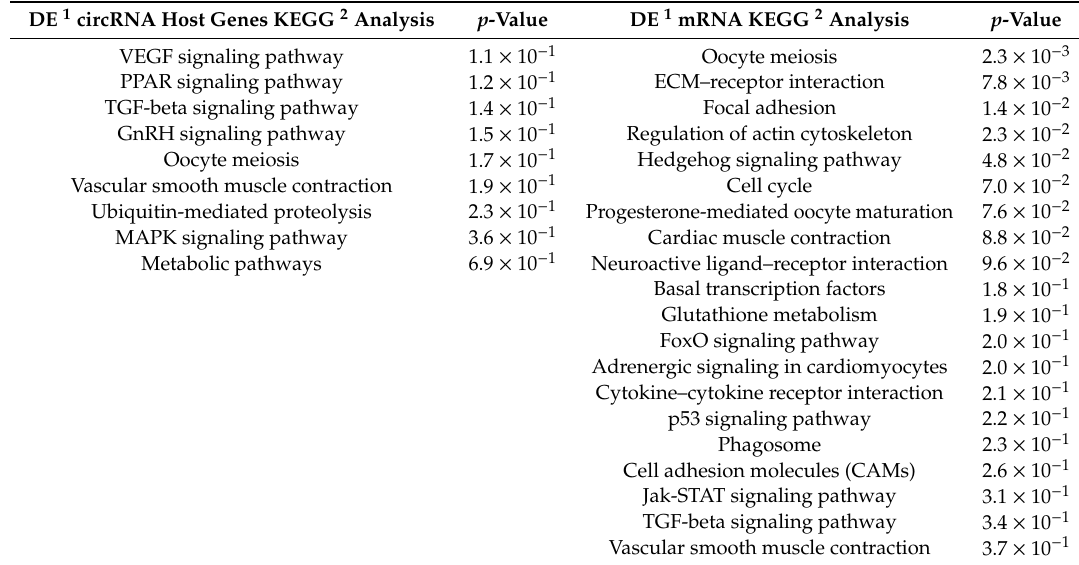
Table 2. Kyoto Encyclopedia of Genes and Genomes (KEGG) enrichment analysis for all di ff erentially expressed transcripts in all